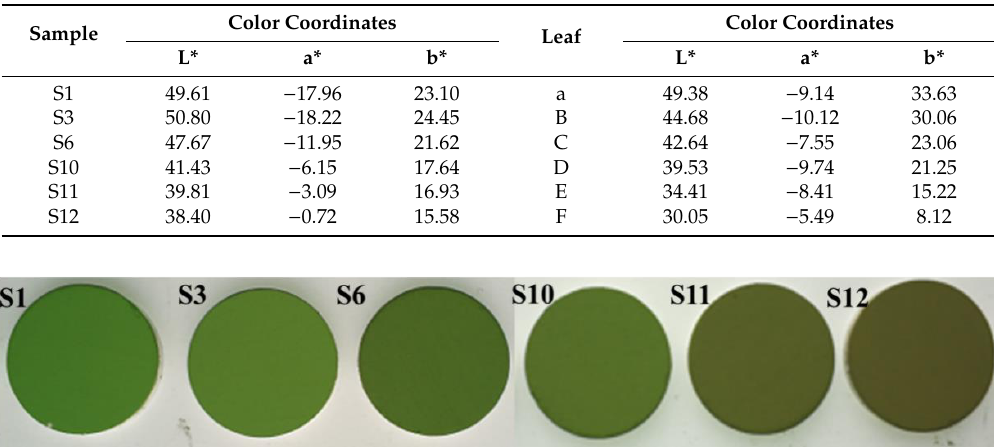
Figure 10. Photographs of Cr 2 O 3 tablets prepared for the color test.